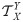
Sample trust paths between nodes A and F in a CDN, where TXY represents the belief and uncertainty pair (BXY, UXY) of Y toward X.